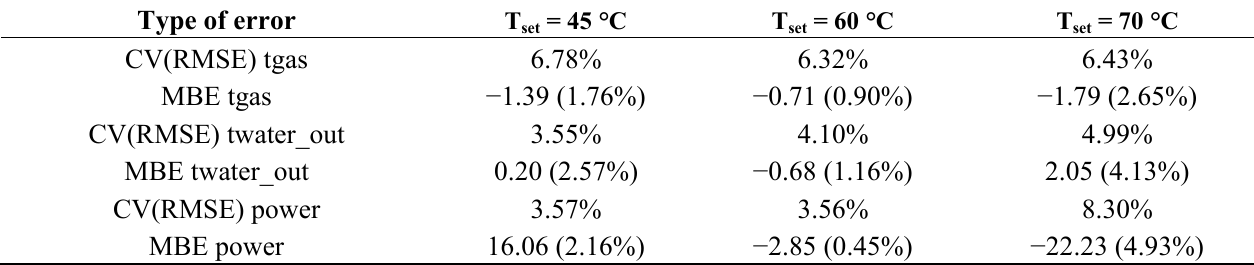
Table 3. Values of CV(RMSE) and MBE for T T set, 3T